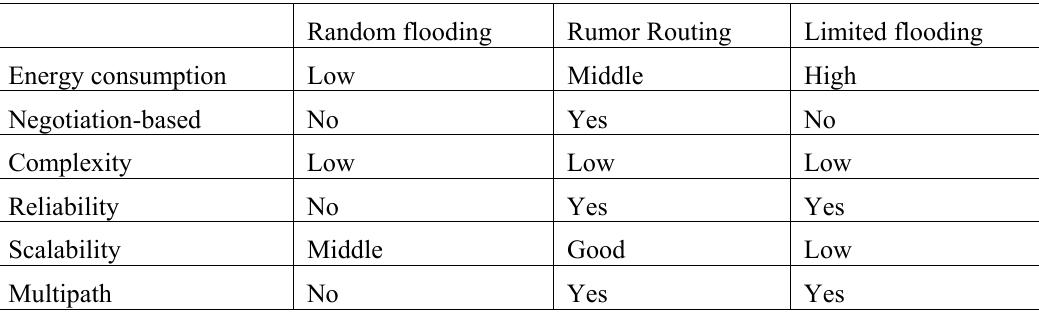
Table 1. Comparison among random flooding, rumor routing and limited